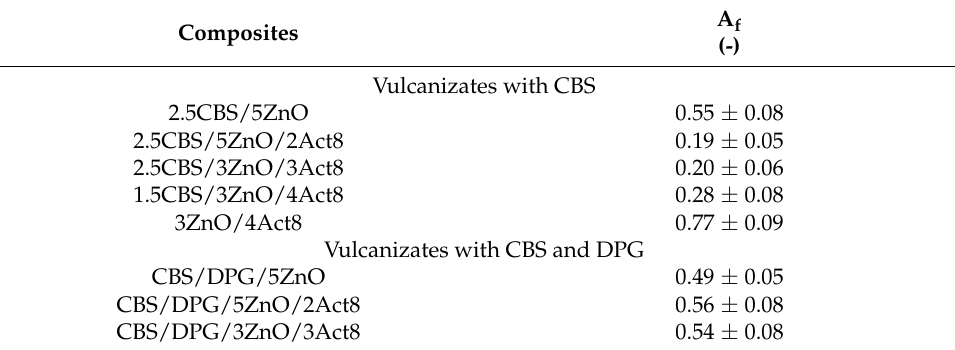
Table 6. Thermo-oxidative aging factor (A f ) of SBR